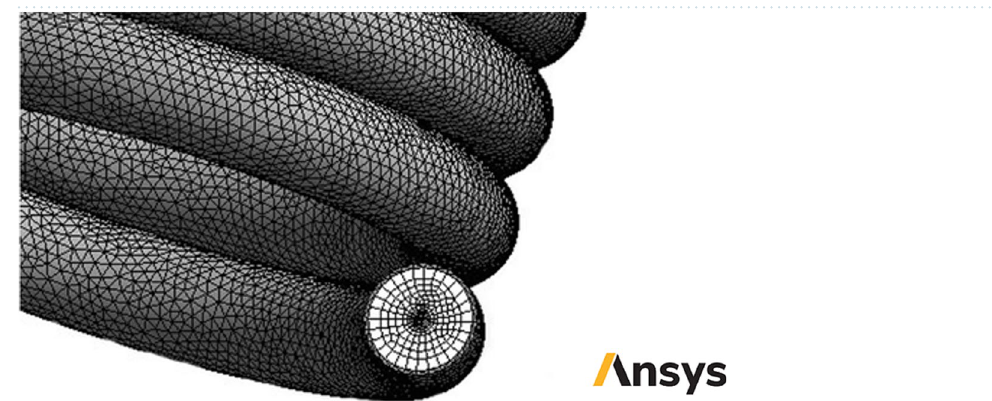
Figure 4. Schematic diagram of boundary conditions in studied helical heat exchanger (Images used courtesy of ANSYS, Inc.).